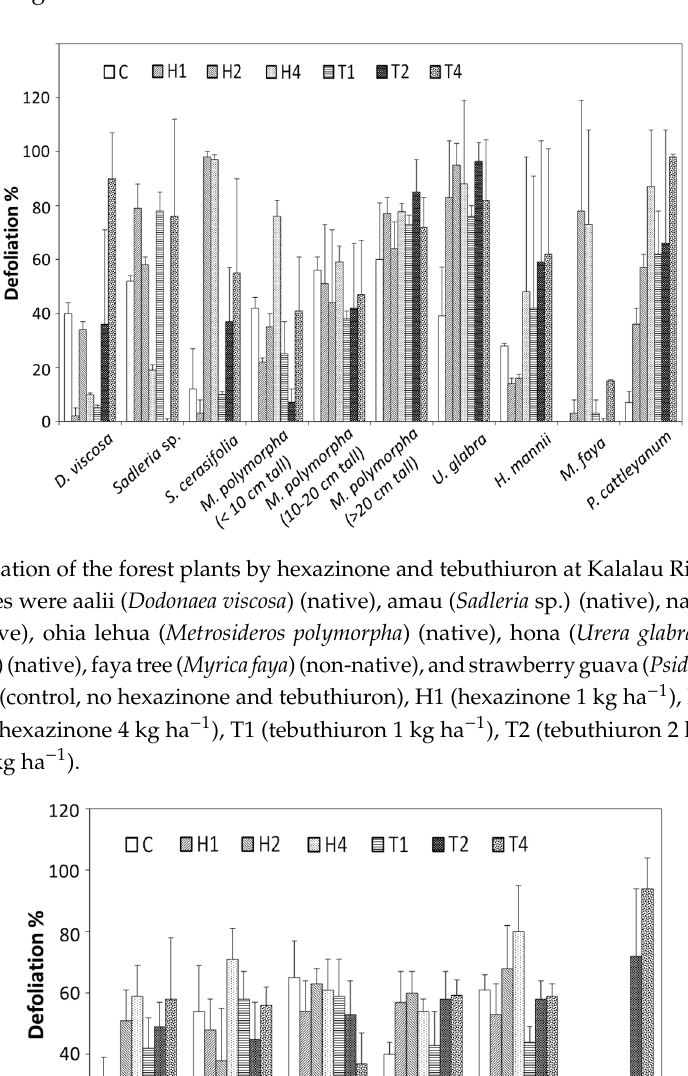
The residual levels of tebuthiuron in the 0-15 cm layer soil at Kalalau Rim site (Site I) collected immediately after spraying at application rates of 1, 2 and 4 kg ha -1 were 896 ± 89, 1623 ± 62, and 3214 ± 97 µg g − 1 dry soil weight (dw), respectively. The corresponding hexazinone residue levels in the 0- 15 cm layer soil at Kalalau Rim site were 239 ± 28, 284 ± 127, and 837 ± 126 µg g -1 dw, respectively, at application rates of 1, 2 and 4 kg ha − 1 . It is noteworthy that there was no documented record that any herbicides were previously used in the two study sites, meaning the background concentration of both hexazinone and tebuthiuron would be undetectable. The concentrations of hexazinone and tebuthiuron were undetectable in the soil samples collected from the control plots. The concentrations of the two herbicides decreased as a function of time, but the concentrations in the deeper layer soil increased as a function of time. For example, the concentrations of tebuthiuron in 0–15 cm, 15–30 cm, and 30–45 cm layers at Kalalau Rim site were 1899 ± 119, 199 ± 42 and 135 ± 39 µg g − 1 dw, respectively, 7 DAT for the application rate of 4 kg ha − 1 as compared with 733 ± 219, 184 ± 47 and 257 ± 69 µg g − 1 , respectively, 180 DAT at the same site. The concentrations of hexazinone in 0-15 cm, 15-30 cm, and 30-45 cm layers at Kalalau Rime site were 1365 ± 749, 614 ±363 and 205 ± 119 µg g − 1 dw, respectively, 7 DAT for the application rate of 4 kg ha − 1 as compared with 348 ± 174, 236 ± 54 and 229 ± 86 µg g − 1 dw, respectively, 180 DAT. The dissipation half-life values (t 1/5 ) of hexazinone and tebuthiuron in the 1–15 cm layer of soils at the two sites were approximately 7 days and greater than 180 days, respectively. The concentrations of hexazinone in the 30–45 cm layer of soils at Kalalau Rim site (Site I) at foliar application rates of 1, 2 and 4 kg ha − 1 were 109 ± 114, 259 ± 73 and 229 ± 86 µg g − 1 dw, respectively, 180 DAT. The concentrations of tebuthiuron in the 30-45 cm layer of soils at Kalalau Rim site at foliar application rates of 1, 2 and 4 kg ha − 1 were 43 ± 38, 137 ± 73, 257 ± 69 µg g − 1 dw, respectively, 180 DAT. The concentrations of hexazinone in the 30–45 cm layer of soils at Kauhao site (mesic site, Site II) at foliar application rates of 1, 2 and 4 kg ha − 1 were 80 ± 61, 62 ± 47 and 69 ± 71 µg g − 1 dw, respectively, 180 DAT. The concentrations of tebuthiuron in the 30-45 cm layer of soils at Kauhao site